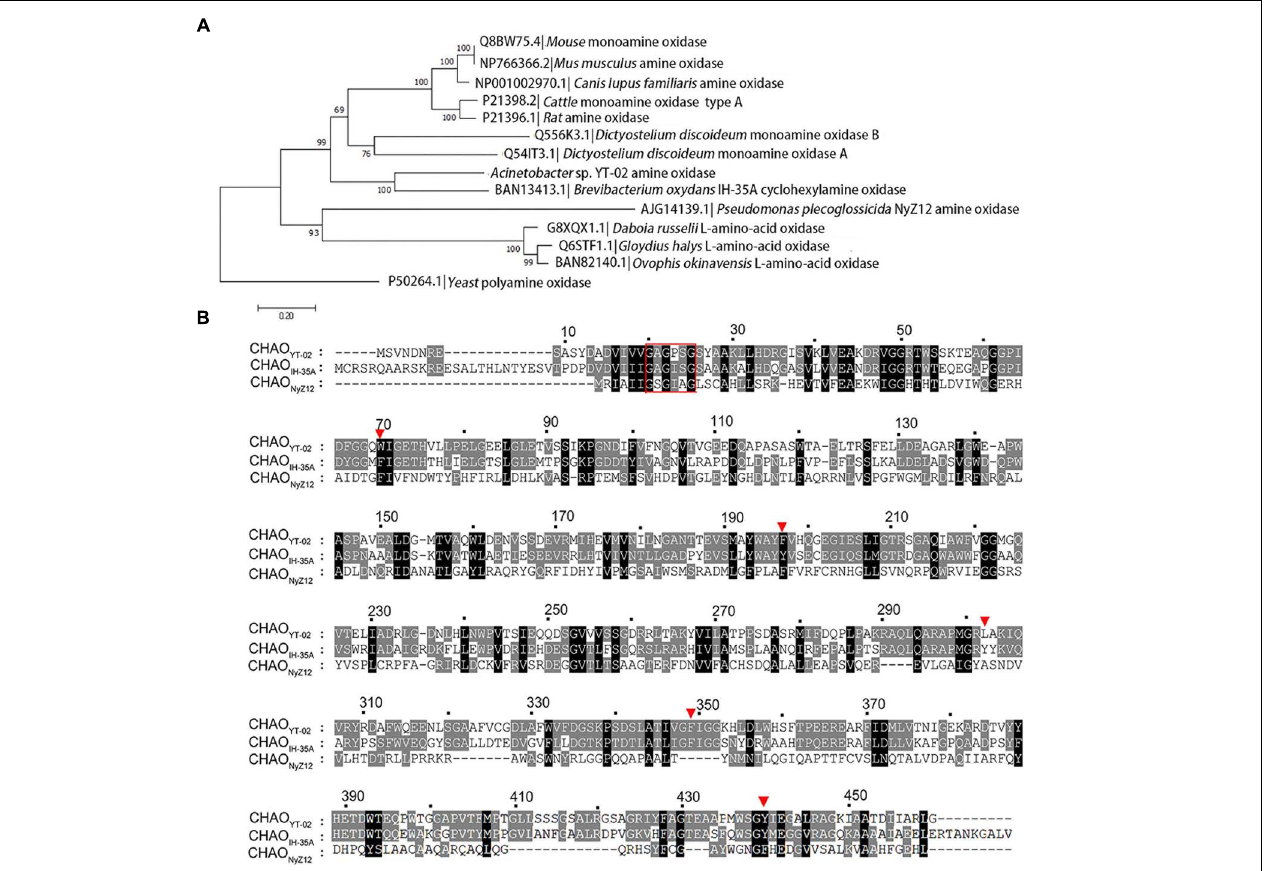
FIGURE 1 | Phylogenetic analysis of cyclohexylamine oxidase (CHAO) and other amine oxidases. (A) Phylogenetic tree of CHAO and other amine oxidases. Amino acid sequences were aligned using Clustal W and phylogenetic tree was constructed by using the neighbor joining method using MEGA 6.0. Amine oxidase from Saccharomyces cerevisiae was used as the outgroup. The numbers at each branch of phylogenetic tree represent the bootstrap value (1000 replicates). (B) Amino acid sequence comparison of CHAO YT − 02 , CHAO NyZ12 , and CHAO IH − 35A . A red rectangular box highlights the putative FAD-binding consensus sequence GXGXXG in the N-terminus of CHAOs. Red triangles indicate amino acids in the active center of the